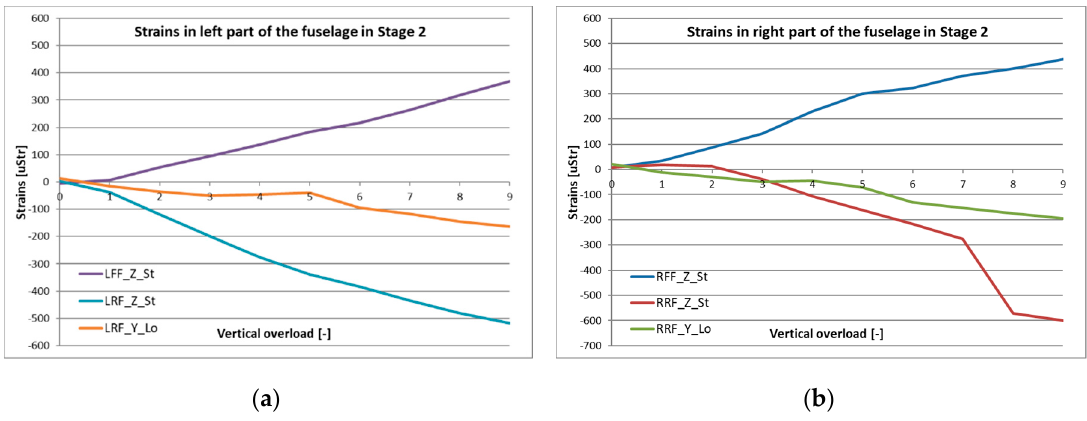
Figure 18. Strain measured in the ( a ) left and ( b ) right side of the fuselage during Stage 2.